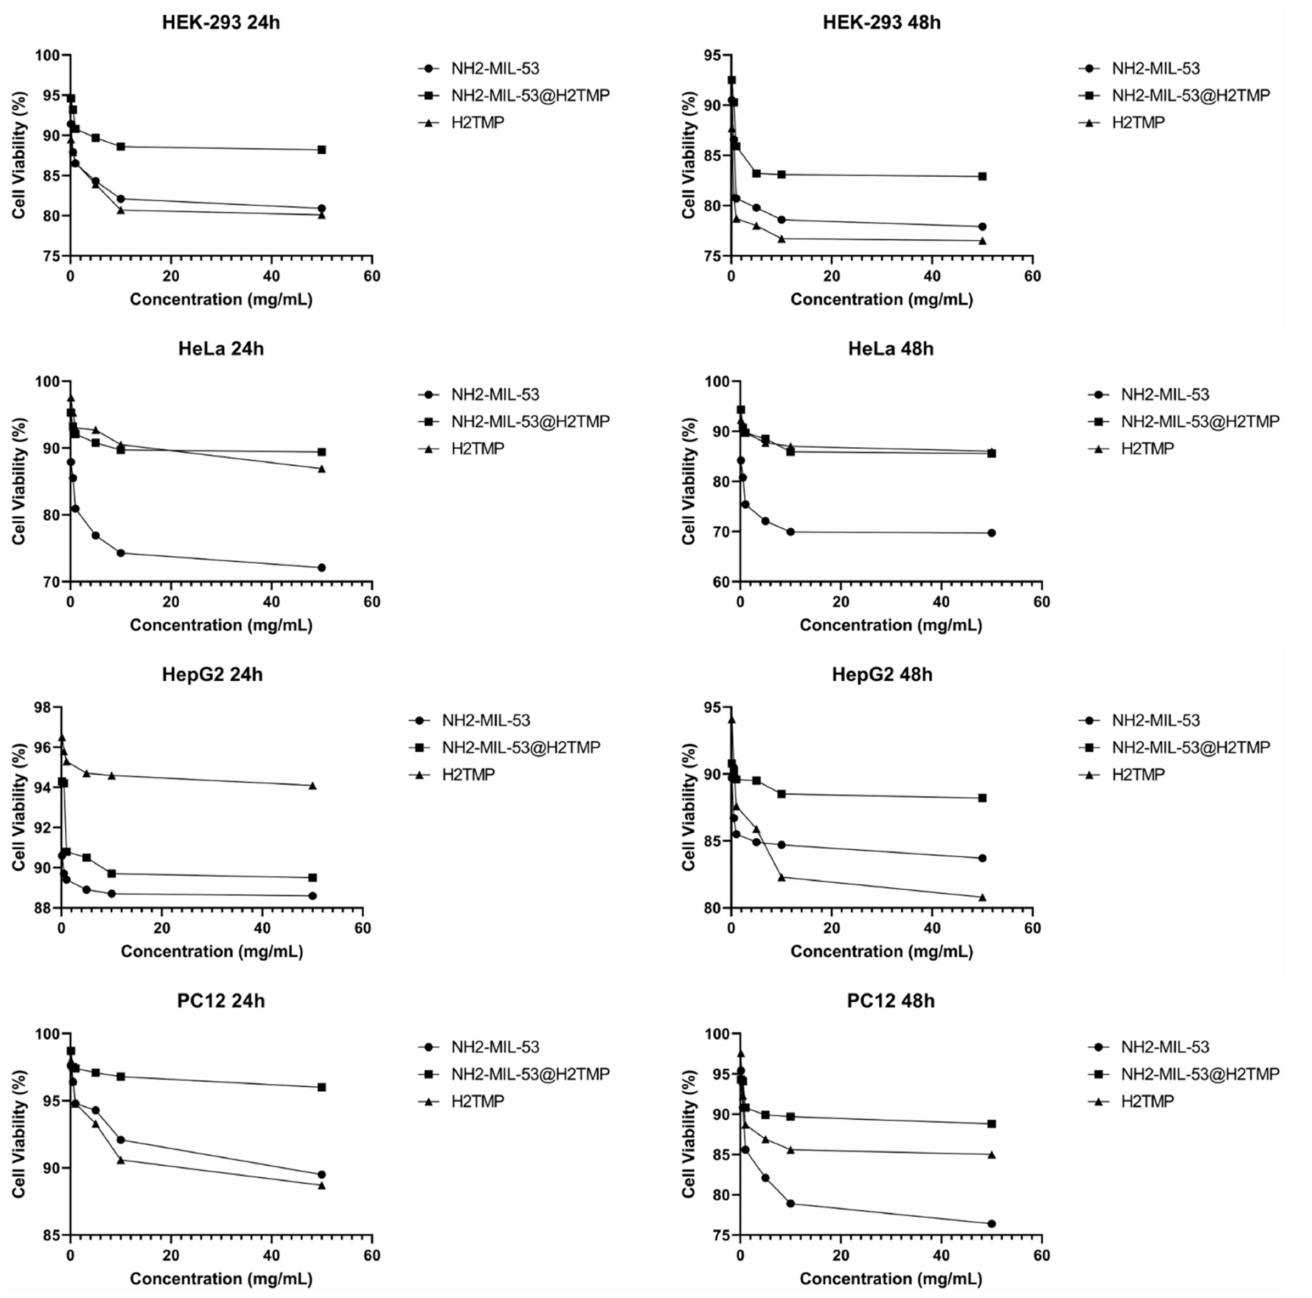
Figure 5. Dose-dependent MTT results of the synthesized